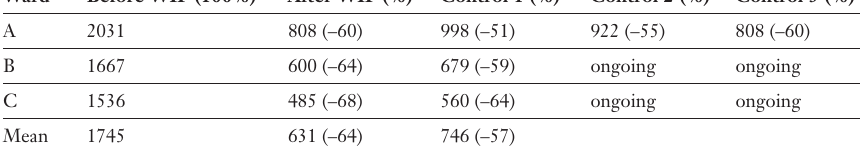
Number of drugs be- fore and after intro- ducing the ward-indi- vidualised formulary